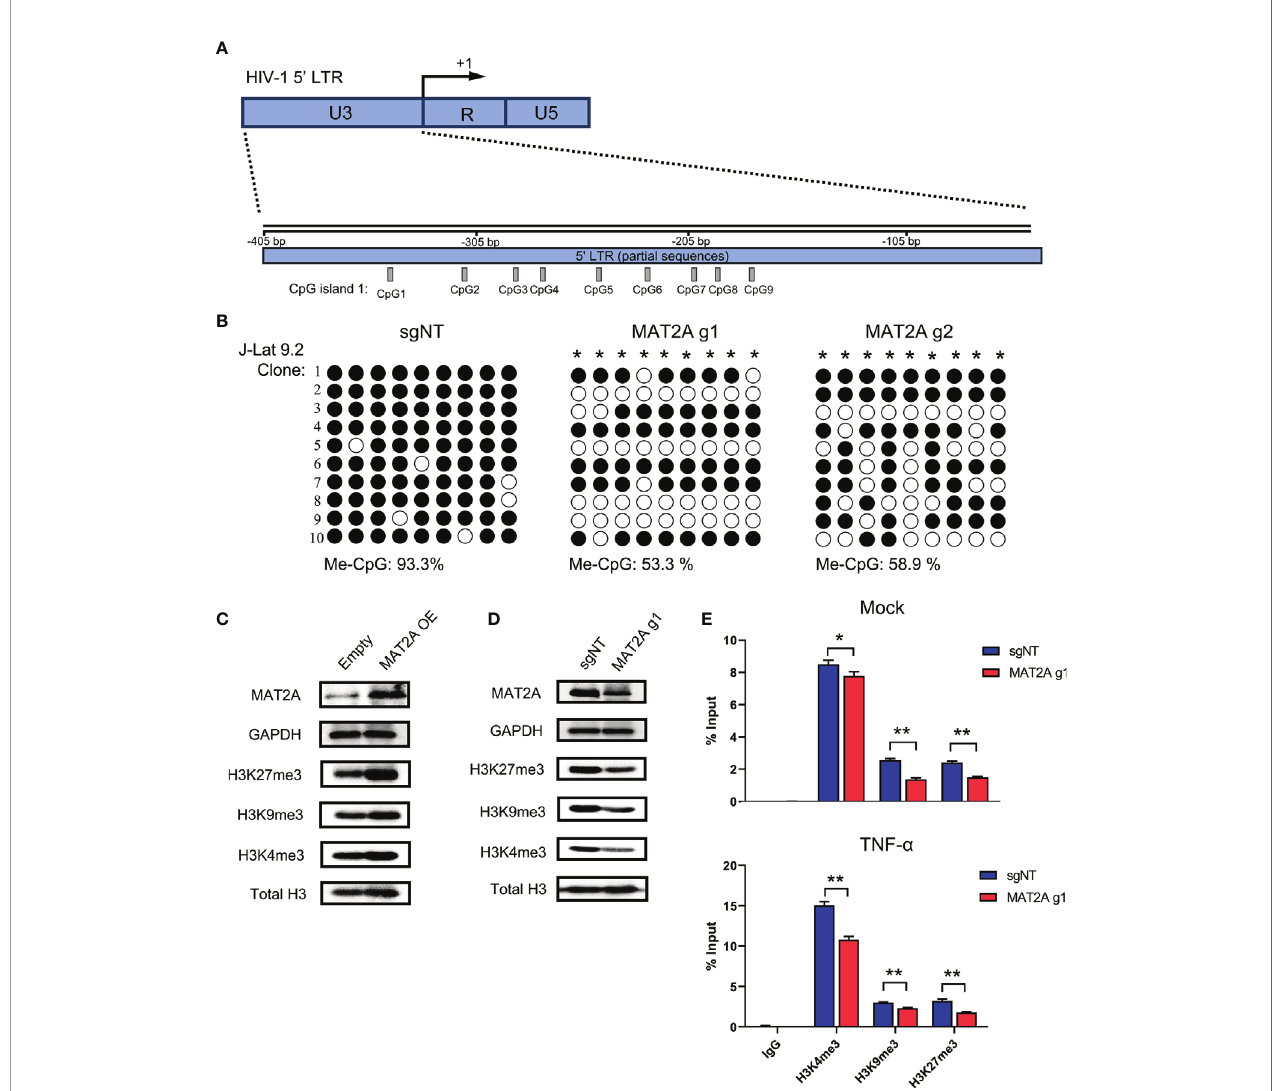
FIGURE 6 | MAT2A regulates HIV-1 latency by modulating LTR DNA and histone methylation. (A) Schematic overview of the CpG island 1 at HIV-1 5 ’ LTR. (B) Bisul fi te- mediated methylcytosine mapping of latent HIV-1 in J-Lat 9.2 cells with MAT2A knockout. sgNT knockout cells served as control. Each column represents one CpG position. Open circles represent nonmethylated CpG residues and closed circles represent methylated CpG residues. Asterisks indicate cytosines with statistically signi fi cant methylation. (C, D) Western blot analysis of MAT2A and methylated histones in J-Lat 9.2 cells with MAT2A overexpression (C) or knockout (D) . GAPDH and total histone H3 were used as loading controls. (E) Measurement of the levels of methylated histones at HIV-1 5 ’ LTR nucleosome nuc-1. ChIP-qPCR assays with antibodies against H3K4me3, H3K9me3, and H3K27me3 were performed in MAT2A knockout J-Lat 9.2 cells with or without TNF- a stimulation. Data were presented as mean ± SD from three independent experiments (Student ’ s t-test, *p < 0.05, **p <